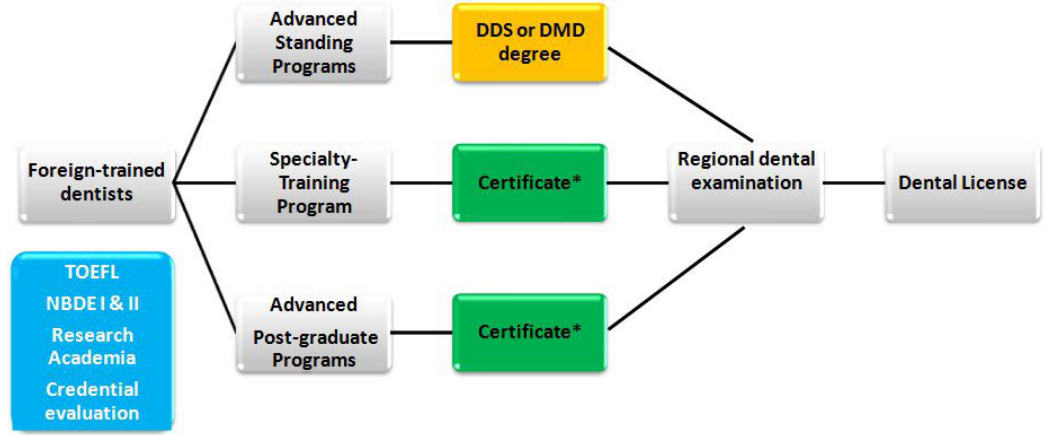
Figure 1. Pathways to licensing for foreign-trained dentists in the United States. * Recognized by a limited number of States.